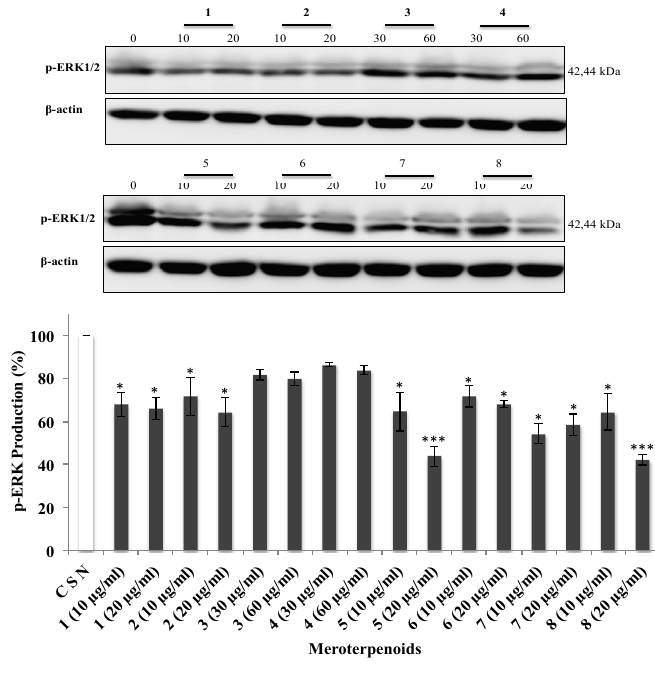
Figure 6. Effect of meroterpenes (AMTs) 1-8 on the activation of extracellular signal-regulated kinase (ERK) by measuring the expression levels of the phosphorylated form (p-ERK) in HT-29 cells. The cells were treated for 24 h with the compounds (10 and 20 μ g/mL for 1 , 2 , 5 , 6 , 7 , and 8 ; 30 and 60 μ g/mL for 3 and 4 ). The levels of p-ERK were measured by Western blot analysis and quantified with Image J analysis software. The result of control groups was set as 100% activity and test groups were compared to this value. The data shown are the means ± SE of three independent experiments. Significant differences from control group: * p < 0.05 and *** p <